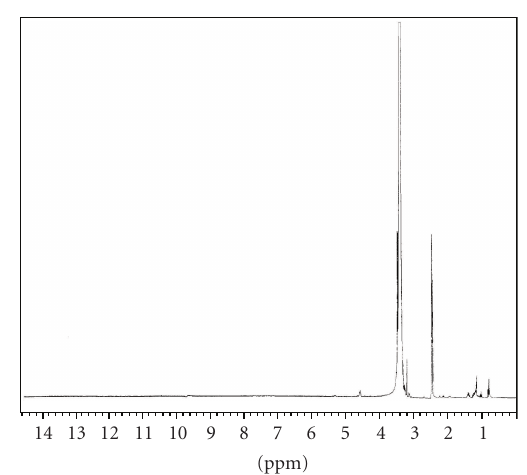
Figure 6: 1 H NMR spectrum of natural rubber.